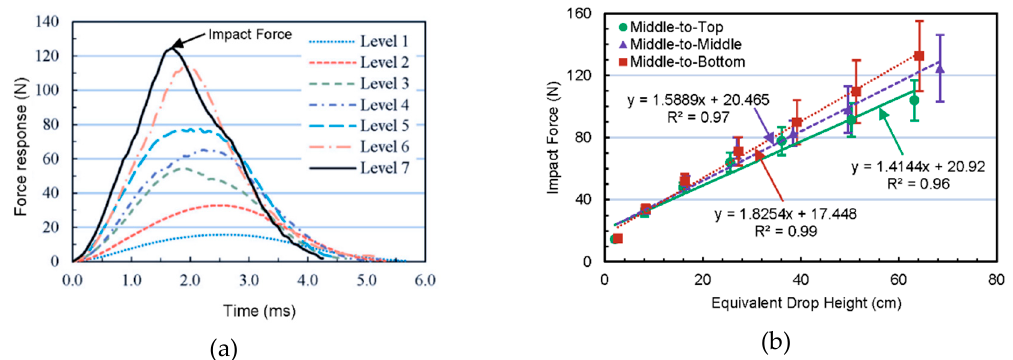
Figure 3. (a) Typical force response-time curves for different impact levels in the same impact zone (middle-to-middle); the greater the impact level, the higher the impact energy it exerted. (b) The linear regression equations between equivalent drop height and impact force for the three impact zones.